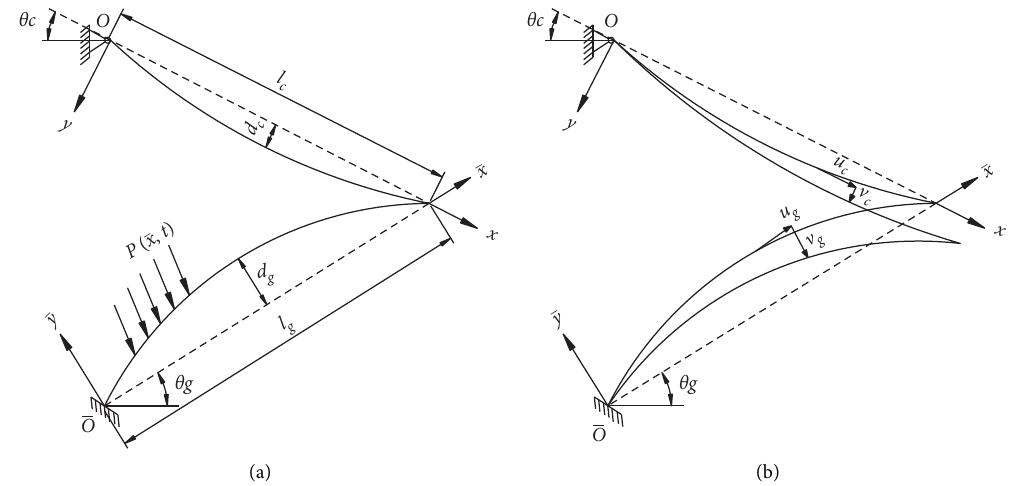
Figure 3: Configuration of a cable-stayed shallow arch: (a) static configuration; (b) dynamic